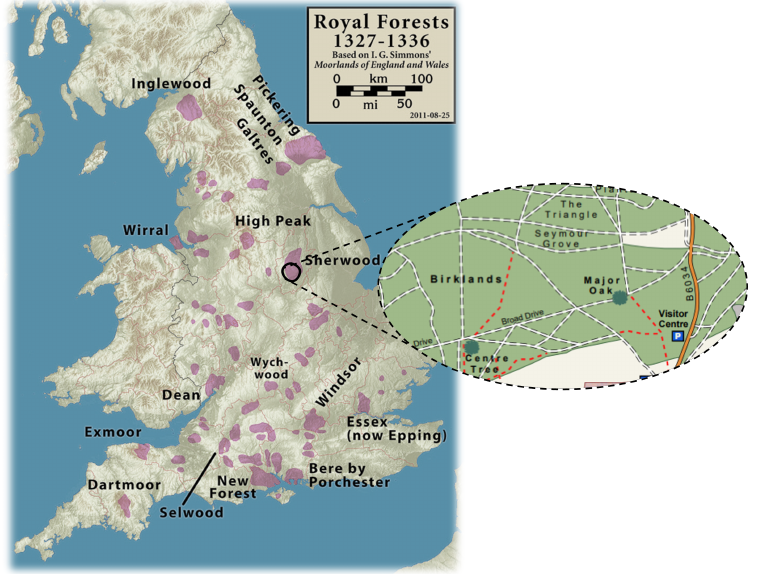
Figure 1. The location of Sherwood highlighted in the